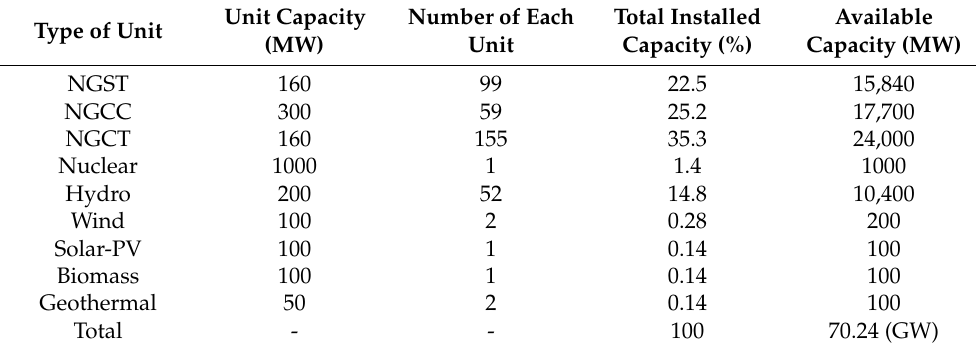
Table 1. Information of current generation units in Iranian power systems [1].